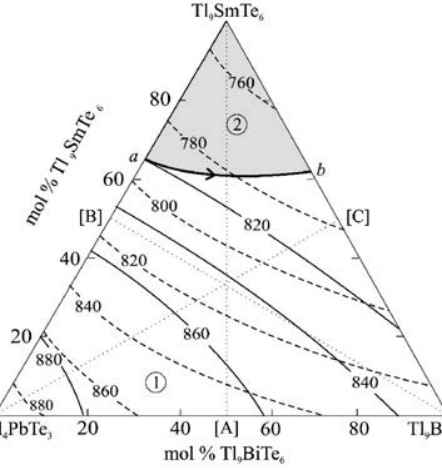
Fig. 4. The liquidus and solidus surfaces projections Tl 4 PbTe 3 -Tl 9 S- mTe